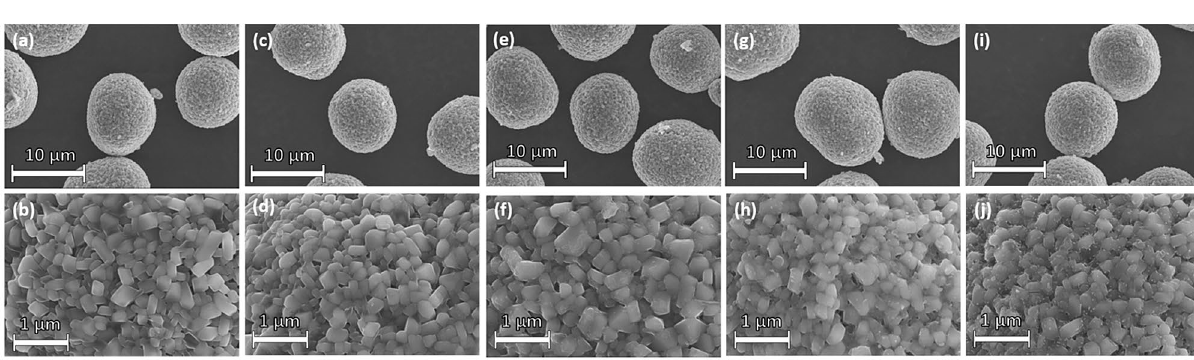
Figure 3. FESEM images of ( a , b ) Pristine, ( c , d ) LiP-0.05, ( e , f ) LiP-0.1, ( g , h ) LiP-0.25 and ( i , j )